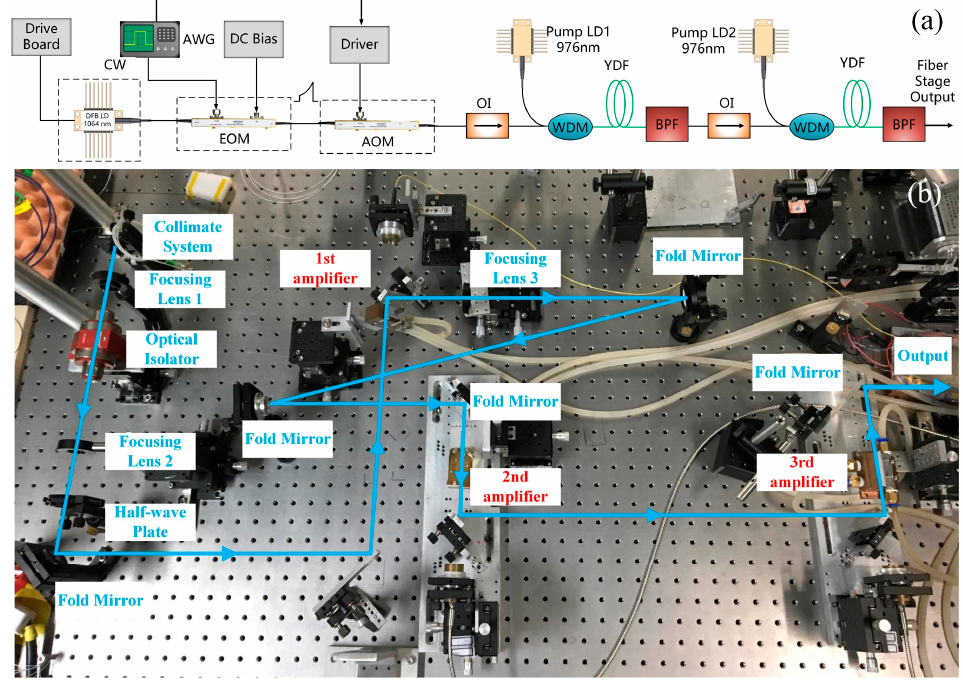
Figure 1. ( a ) Schematic of the fiber stage. OI: optical isolator; WDM: wavelength division multiplex; YDF: Ytterbium doped fiber; BPF: band pass filter (5 nm). ( b ) Photo of setup of solid-state laser amplifiers.